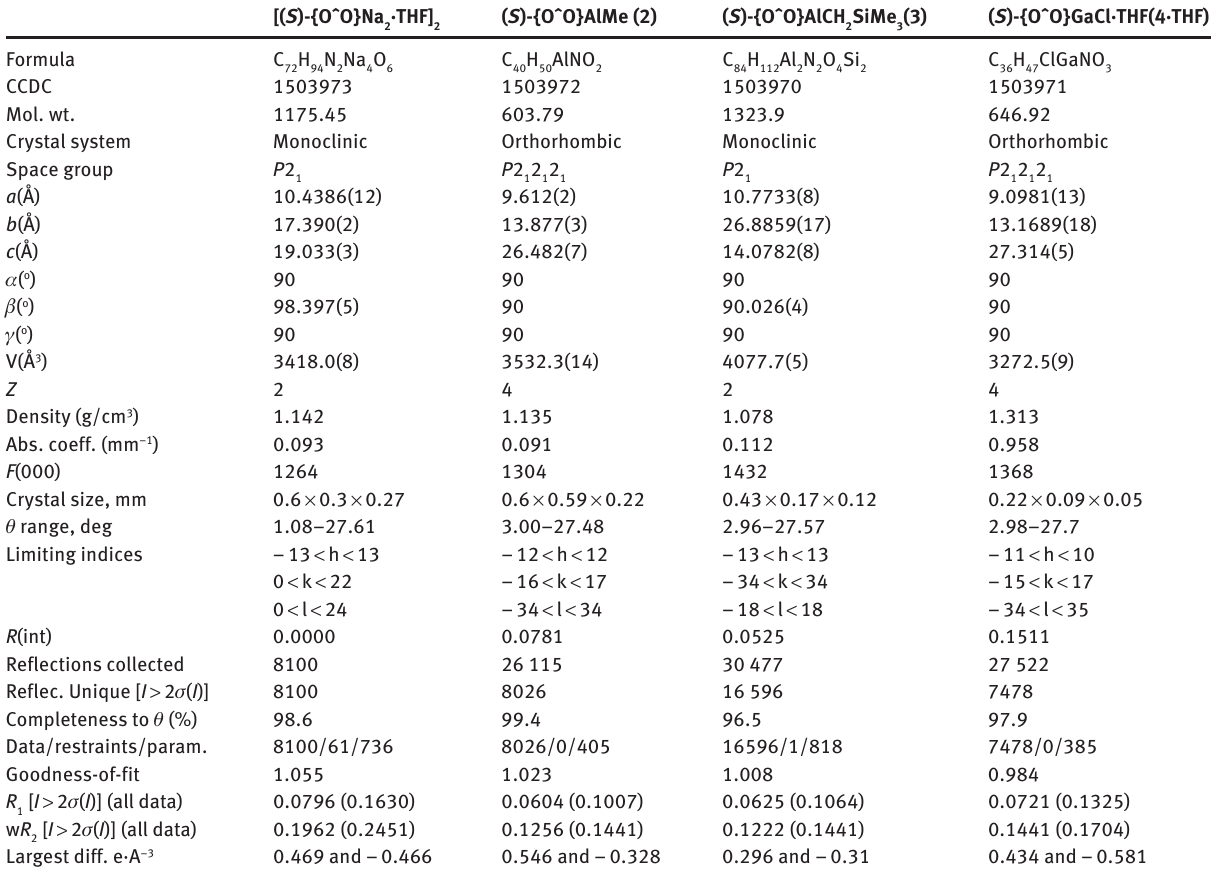
Table 1: Summary of the crystallographic